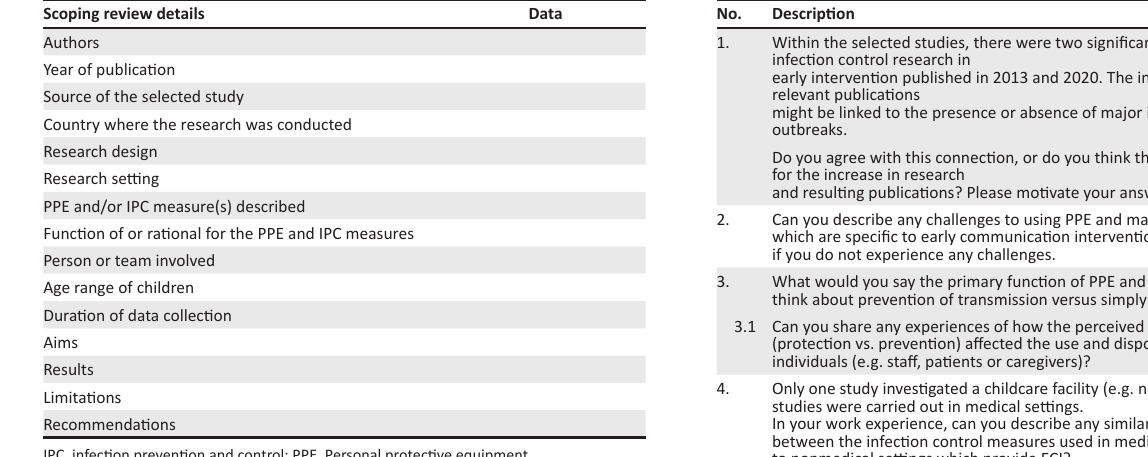
TABLE 1-A2: Data charting table. TABLE 1-A3: Consultation phase (step 6): Interview